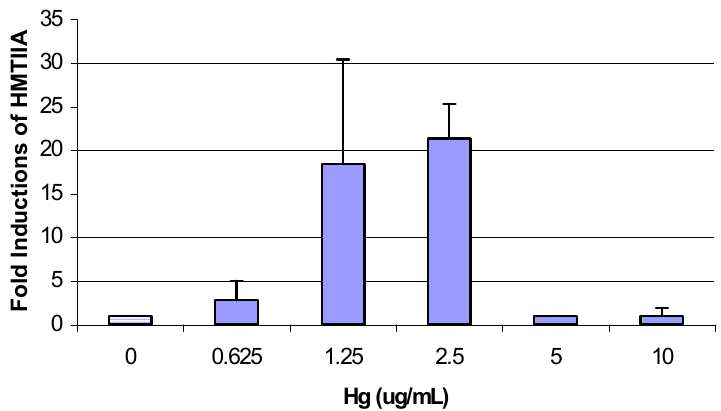
Figure 3. Fold induction of HMTIIA in HepG means ± SDs, n =